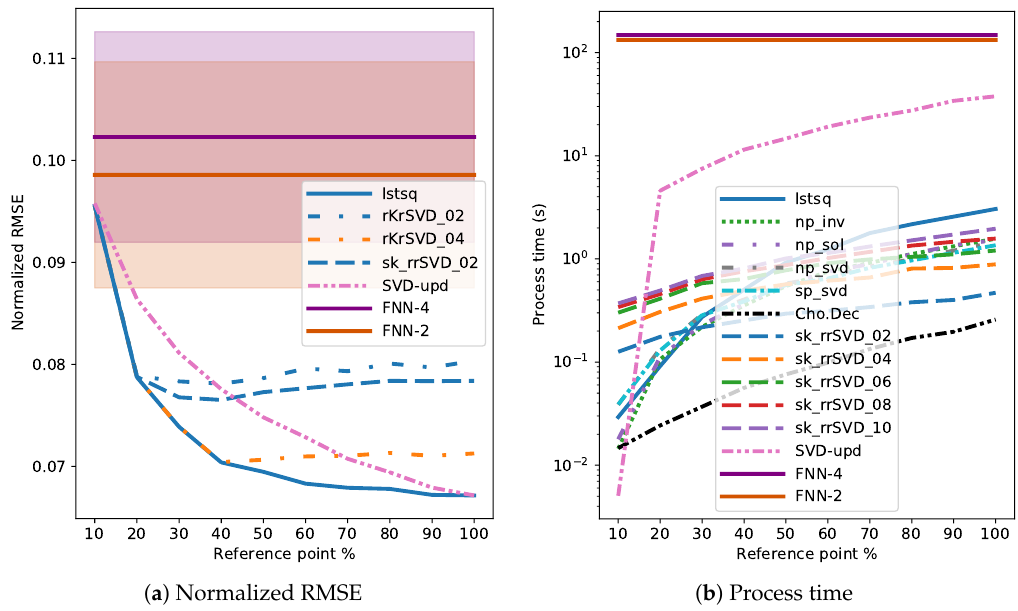
Figure A2. Normalized RMSE values ( a ) and process time in seconds taken to compute Equation (1) ( b ) as a function of reference point percentage for the Boston Housing dataset. In ( a ) for MLM, only methods that at any reference point percentage differ from Lstsq with Kruskal–Wallis H test are shown along Lstsq